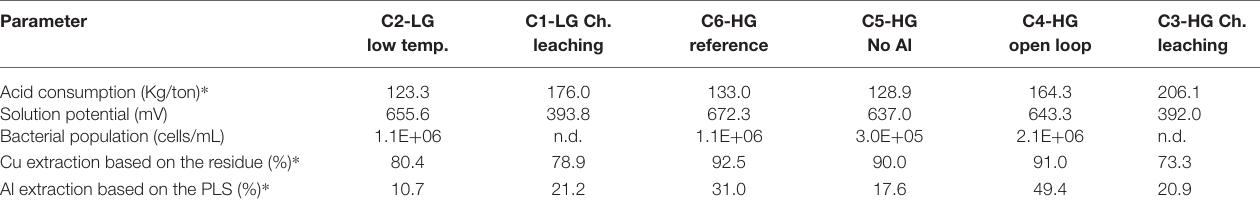
C1-LG Ch. leaching